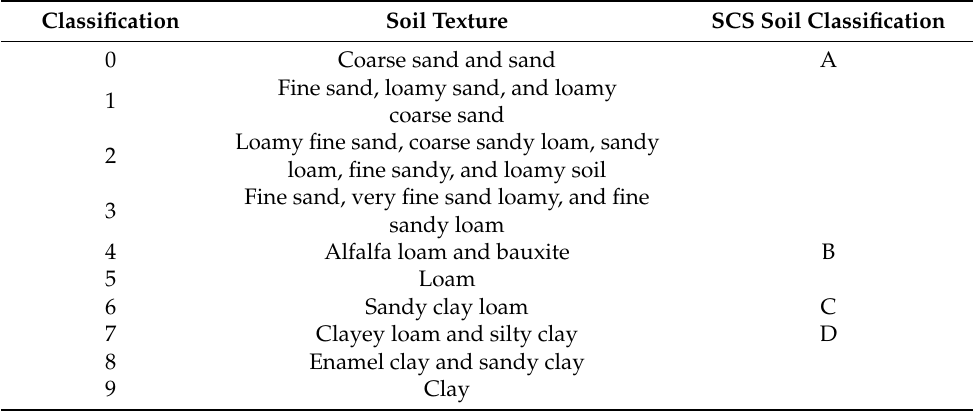
Table 2. Soil category of SWCB and the corresponding that of SCS.